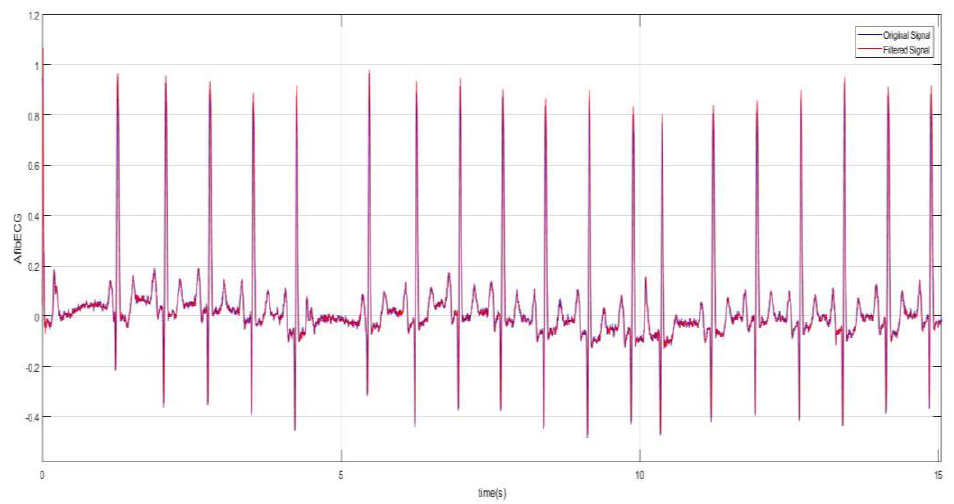
Figure 9. AF filtered ECG signal plotted for 15 s (data obtained from the MIT-BIH database).